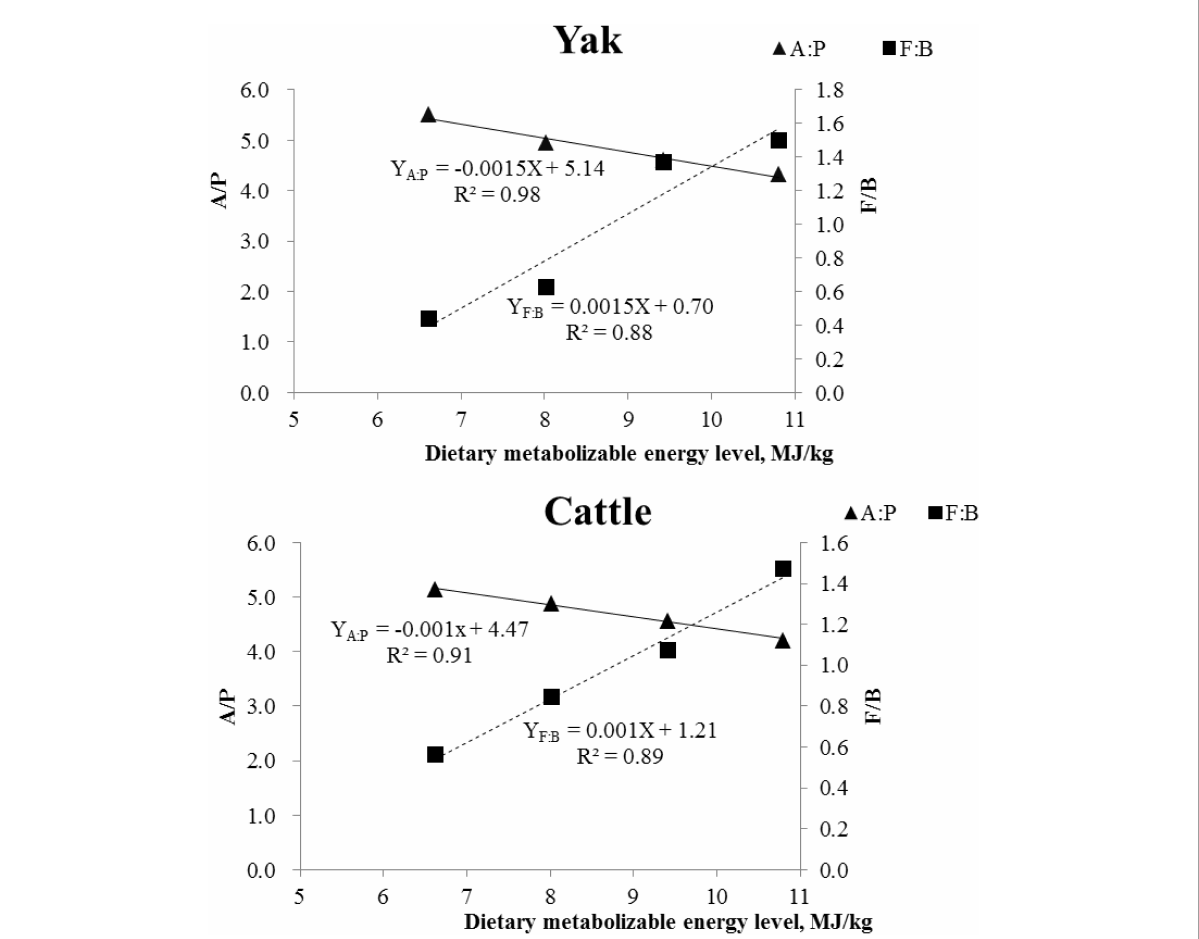
FIGURE4 Correlation between average daily gain and Firmicutes/Bacteroidetes (F/B; ) ratio, and acetate/propionate (A/P; ) ratio in yaks and in Qaidam cattle.